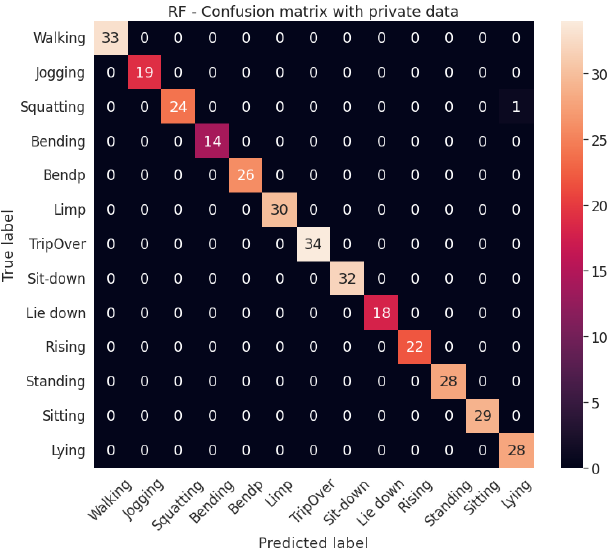
Fig 18. Classification result for RF algorithm on the private